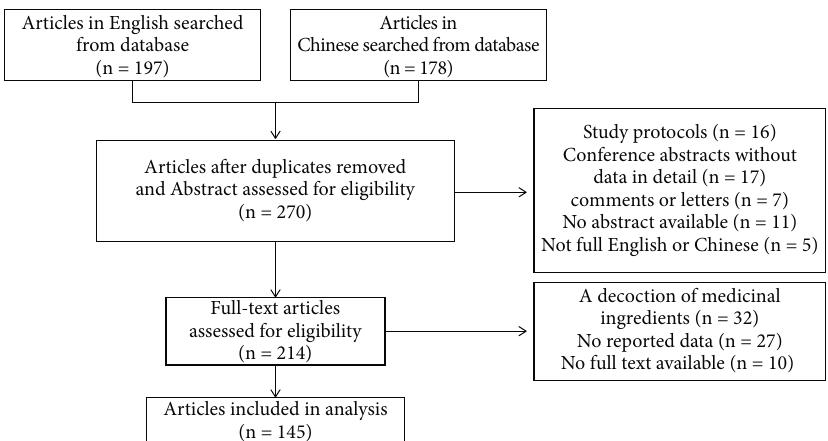
Figure 2: Flow chart of literature